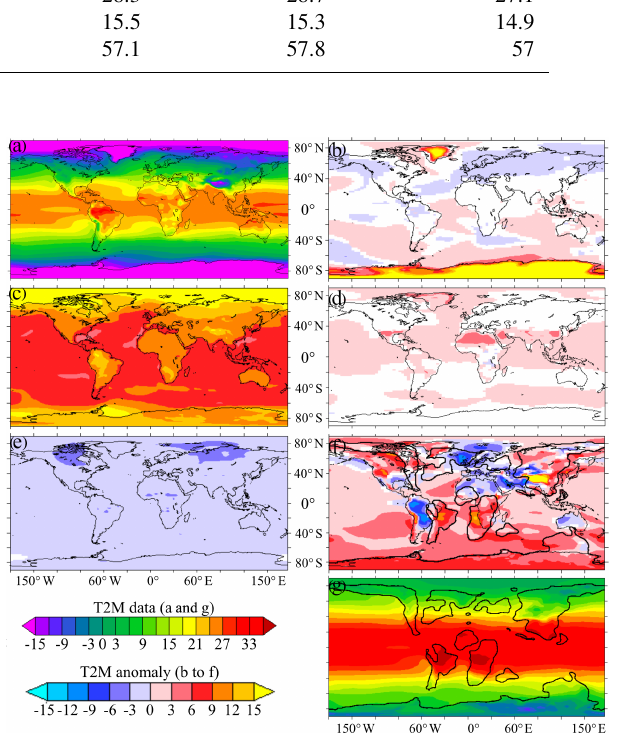
Figure 4. T2M ( ◦ C) for (a) piControl initial simulation and (g) Cretaceous final simulation and anomalies ( ◦ C) for in- termediate simulations: (b) 1X-NOICE − piControl, (c) 4X- NOICE − 1X-NOICE, (d) 4X-NOICE-PFT-SOIL − 4X-NOICE, (e) 4X-NOICE-PFT-SOIL-SOLAR − 4X-NOICE-PFT-SOIL and (f) 4X-CRETACEOUS − 4X-NOICE-PFT-SOIL. White colour (not represented in the colour bar) correspond to areas where the anomaly is not statistically significative according to Student’s t